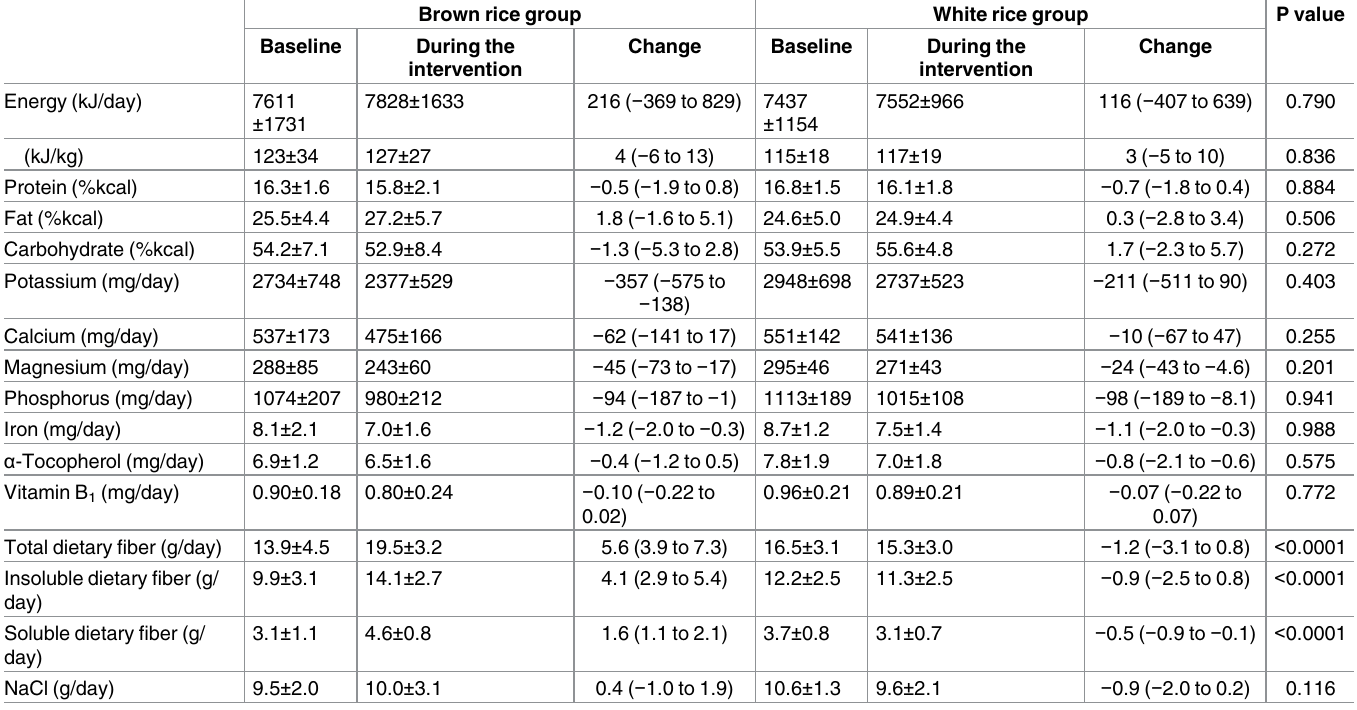
Table 2. Nutritional intake at baseline and during the dietary intervention. Brown rice